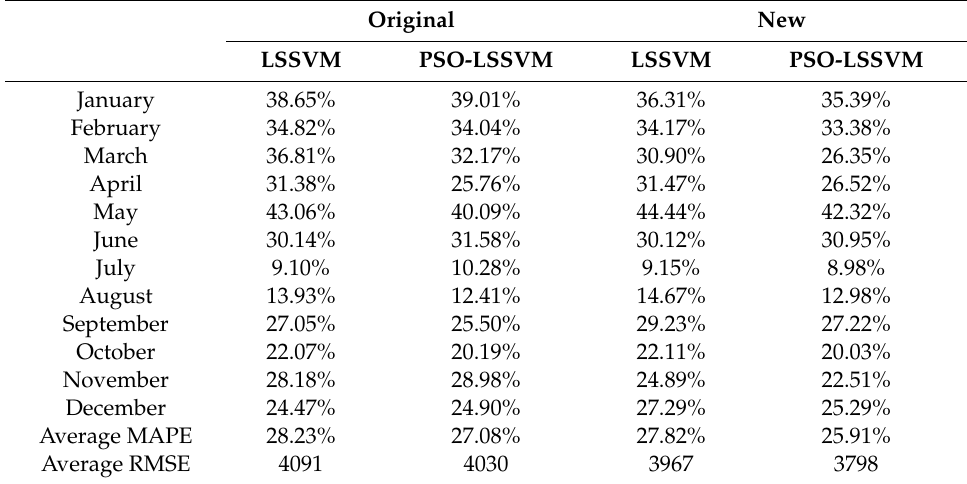
Table 8. Results of the predictions by PSO-LSSVM and LSSVM under di ff erent definitions of seasons. Original